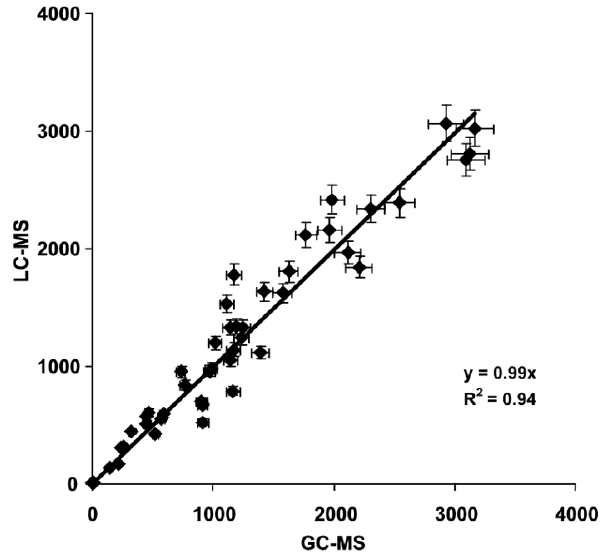
Figure 2. Correlation between LC-MS results and GC-MS results for levoglucosan. (50 2 Fig. 2. Correlation between LC-MS results and GC-MS results for levoglucosan. (50 samples analysed). Concentrations are in ngm − 3 samples analysed). Concentrations are in ng.m-3 in air. Error bars represent the RSD. 3 in air. Error bars represent the